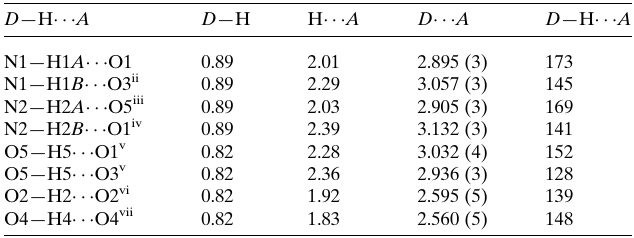
Table 2 Hydrogen-bond geometry (A˚ , (cid:5) ).